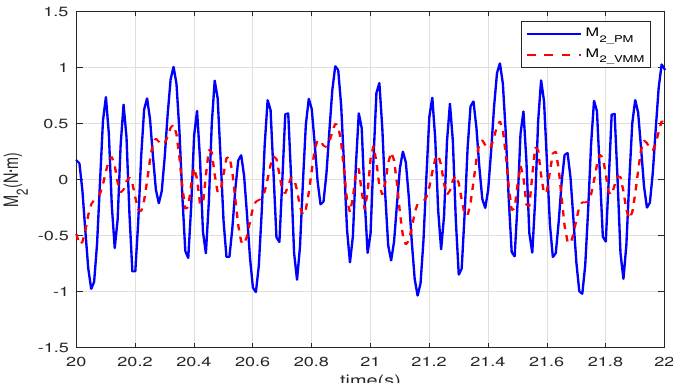
Figure 9. The output torque of the second joint.